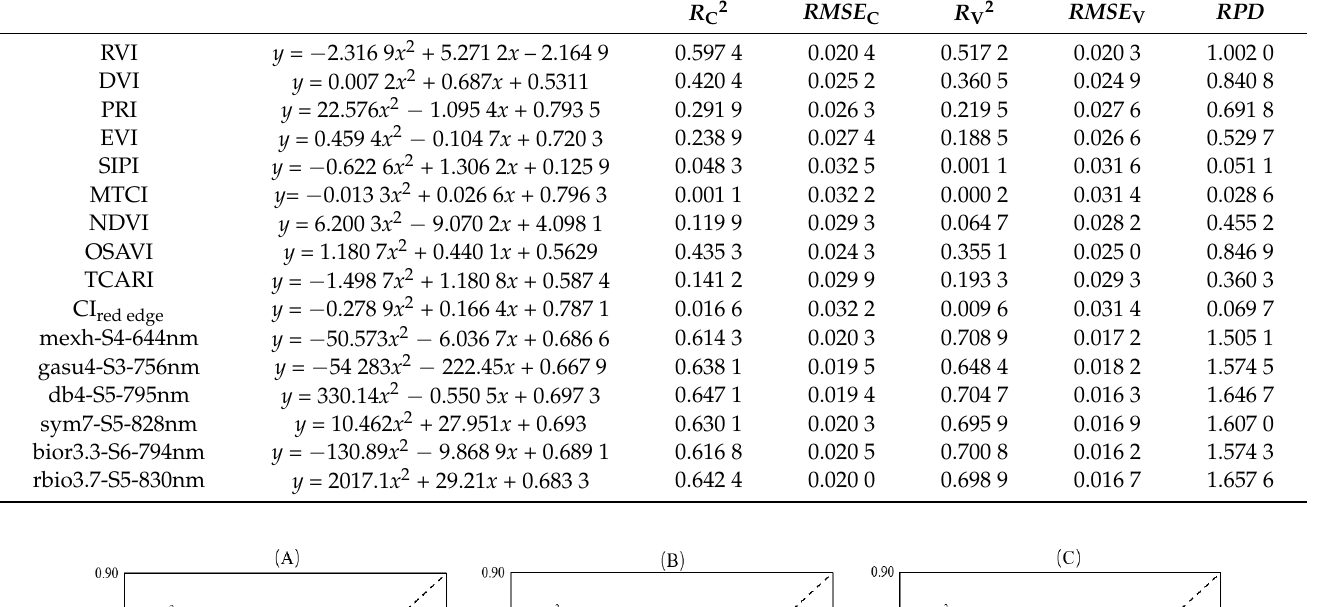
Table 5. Performance of models for estimating Fv/Fm based on VIs and wavelet features.